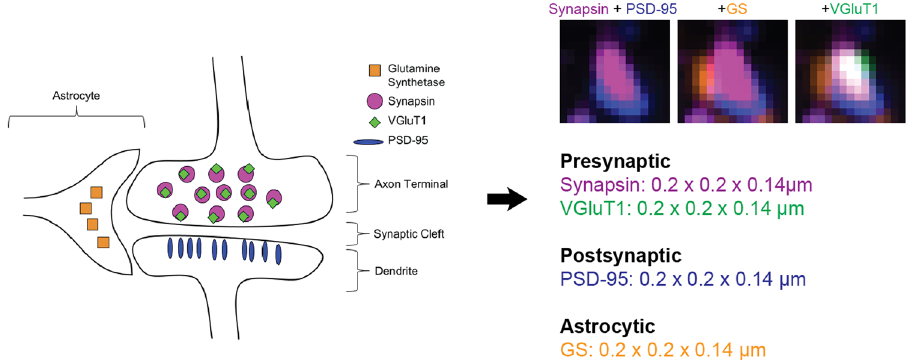
Figure 1. Outline of a query. The cartoon on the left side shows the relative spatial arrangement of the different fluorescent markers used to detect an excitatory synapse expressing VGluT1, next to an astrocyte process. This visual description of a synapse is translated into a query, shown to the right of the large black arrow. A query is a user-defined description of what the synapse type of interest should ‘look’ like. In this case, the presynaptic protein markers - synapsin and VGluT1, are expected to colocalize (occupy the same 3D space) with each other. Furthermore, the presynaptic, postsynaptic, and astrocyte markers (as a group) are all expected to be next to each other. The top right portion of the figure shows three 1.5 μ m × 1.5 μ m cutouts of different marker combinations showing what the query looks like in the data. The first cutout shows the synapsin and PSD- 95 punctum overlaid; the second cutout includes the GS punctum and the third cutout includes the VGluT1 punctum.